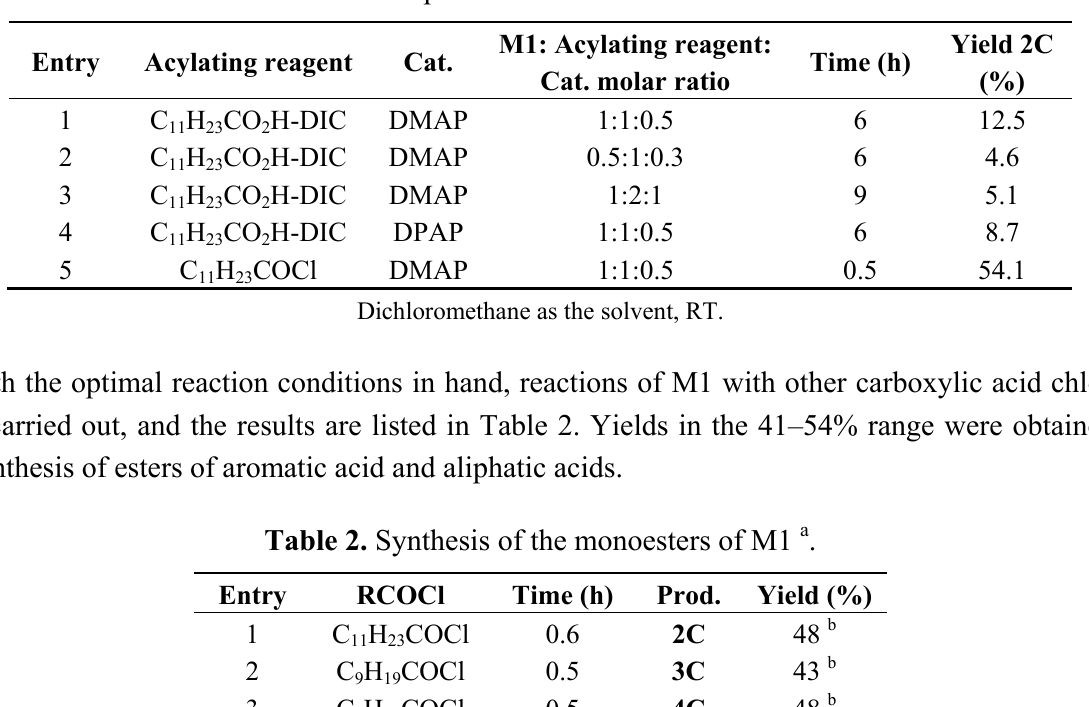
Table 1. The optimization of reaction conditions.